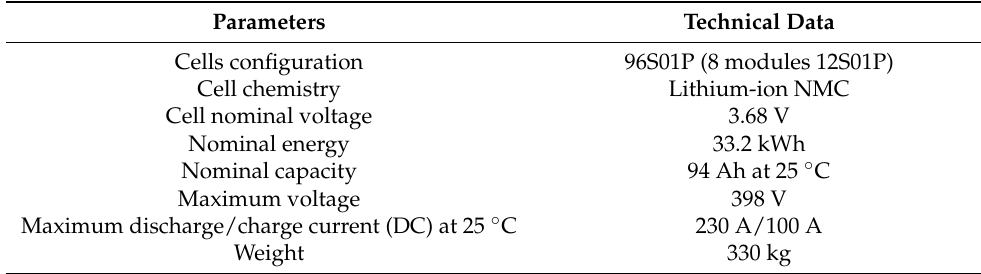
Table 3. Traction battery pack